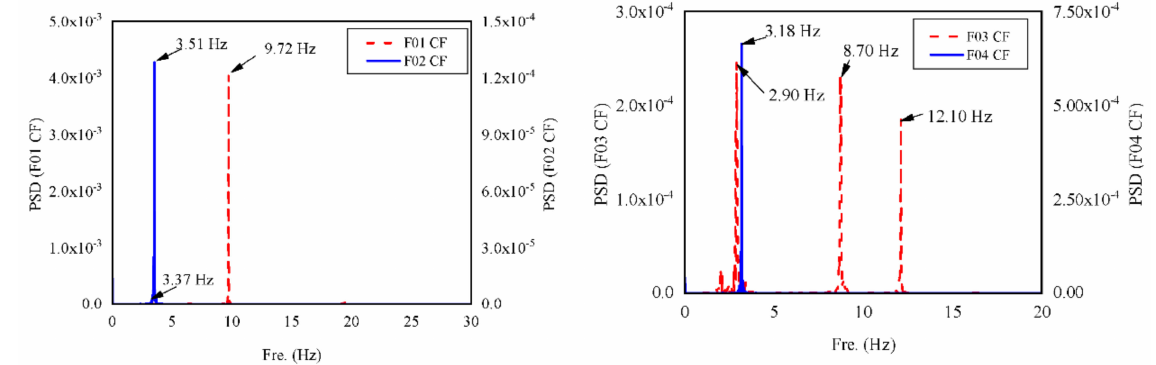
Figure 6. FFT results of VIV responses under uniform flow (1.6